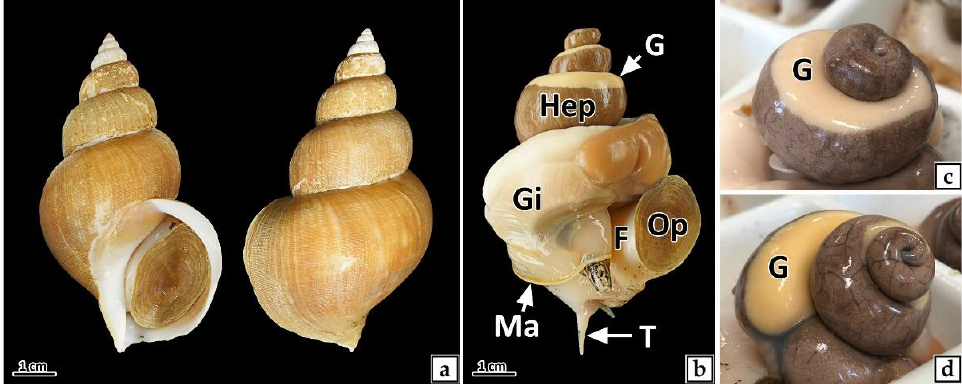
Figure 3. Morphology ( a ), anatomy ( b ) and gonad (( c ): female, ( d ): male) of Buccinum osagawai . F: foot; G: gonad; Gi: gill; Hep: hepatopancreas; Ma: mantle; Op: operculum; T: tentacle. Upon histological analysis of the gonads of all specimens ( n = 549), synchronous hermaphrodites were not observed, and it was possible to distinguish between males and females in the gonadal inactive stage. The overall sex ratio (F:M) was 1:1.2 ( n = 549, F = 250, M = 299), with a higher proportion of males. As the size of individuals increased, the proportion of males tended to decrease (Table 1). Table 1. Sex ratio (F:M) with shell height (SH) of Buccinum osagawai . SH